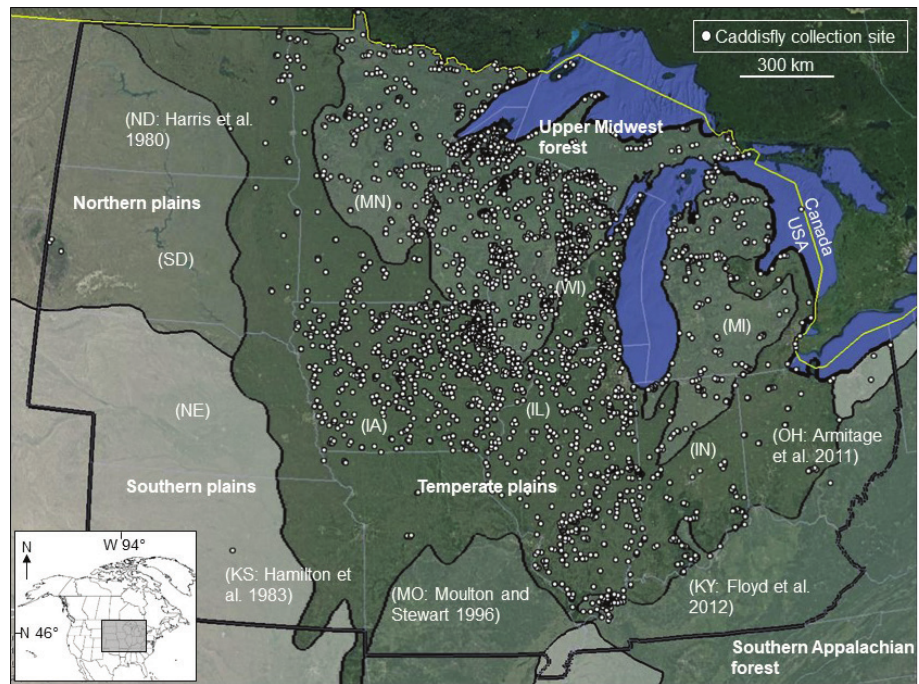
Figure 1. The 13 states and primary ecoregions of the Upper Midwest region, showing collecting locali- ties within the last ~20 years by the authors or their colleagues. Citations are the most comprehensive taxonomic works for states where our collecting effort was low. State abbreviations, IA: Iowa, IL: Illinois. IN: Indiana, KS: Kansas, KY: Kentucky, MI: Michigan, MN: Minnesota, MO: Missouri, NE: Nebraska, ND: North Dakota, OH: Ohio, SD: South Dakota, WI: